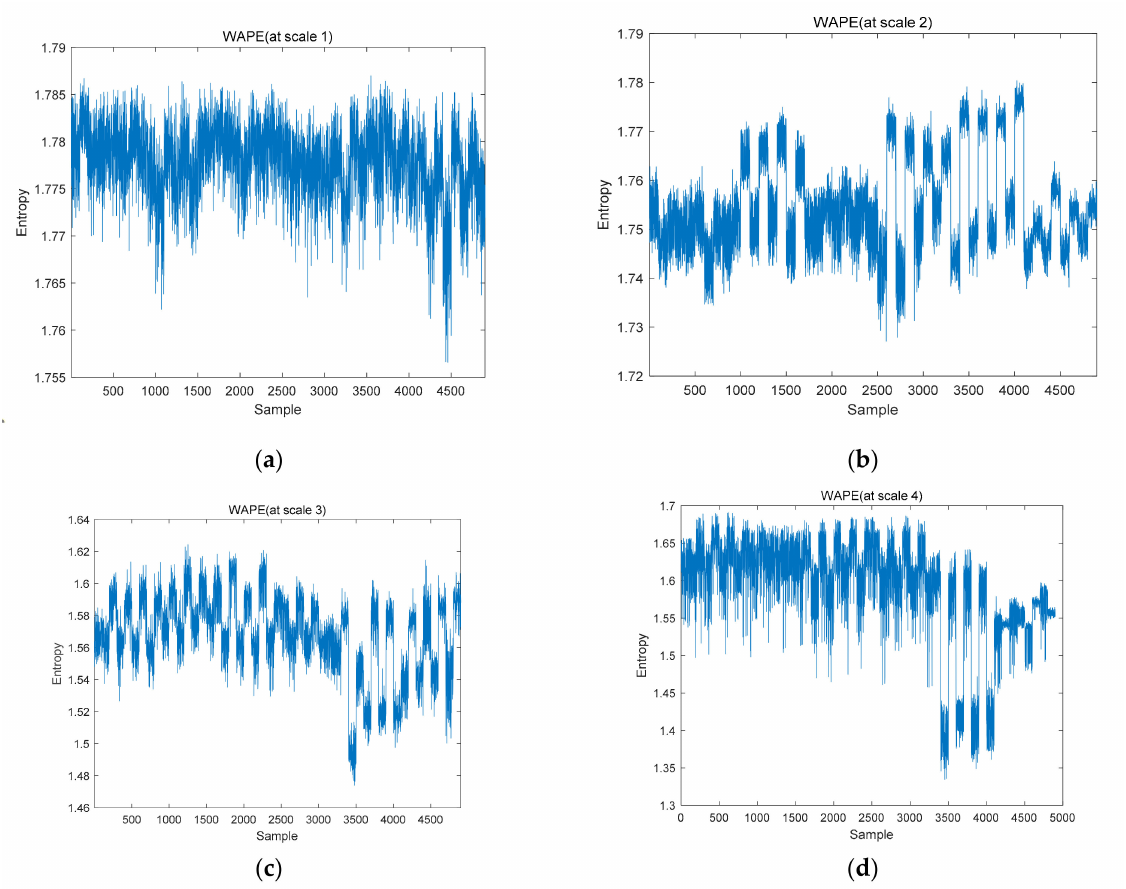
Figure 4. WAPE at different scales: ( a ) WAPE at scale 1; ( b ) WAPE at scale 2; ( c ) WAPE at scale 3; ( d ) WAPE at scale